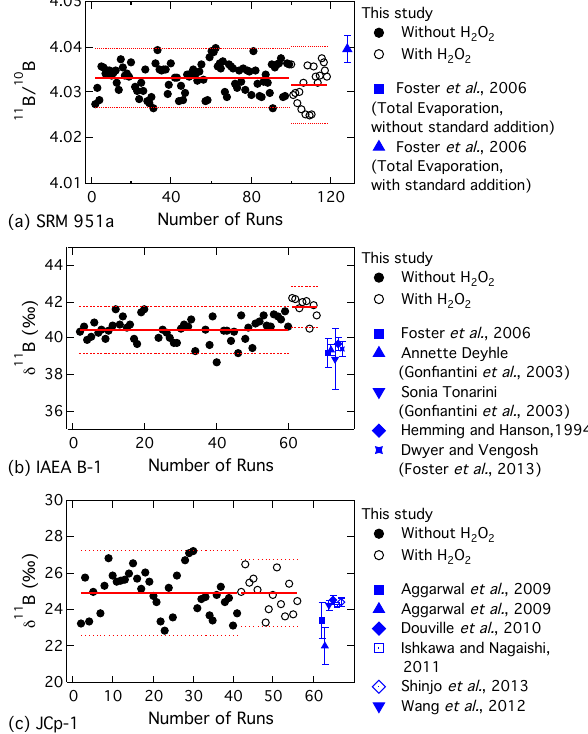
Figure 4. Long-term precision of (a) boric acid standard SRM 951a, (b) seawater standard IAEA B-1, and (c) inter-laboratory carbonate standard